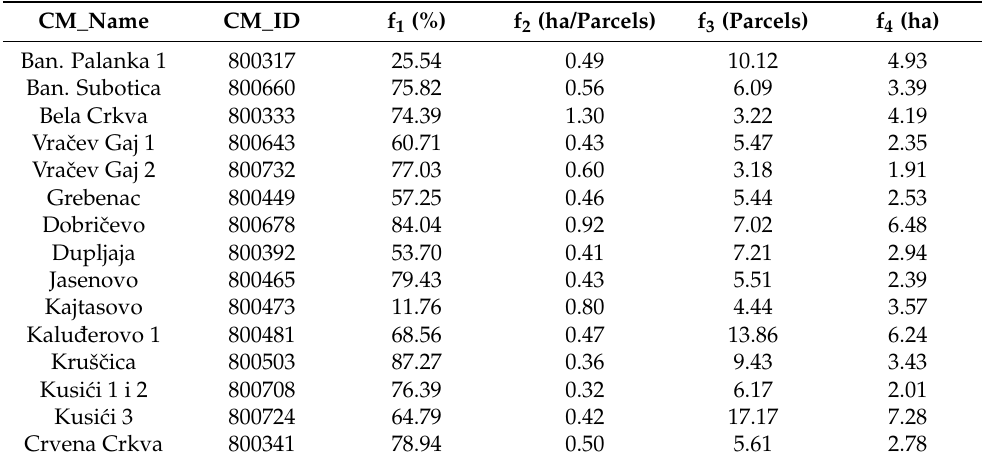
Table 1. Data taken from the database of the RCD of Bela Crkva.